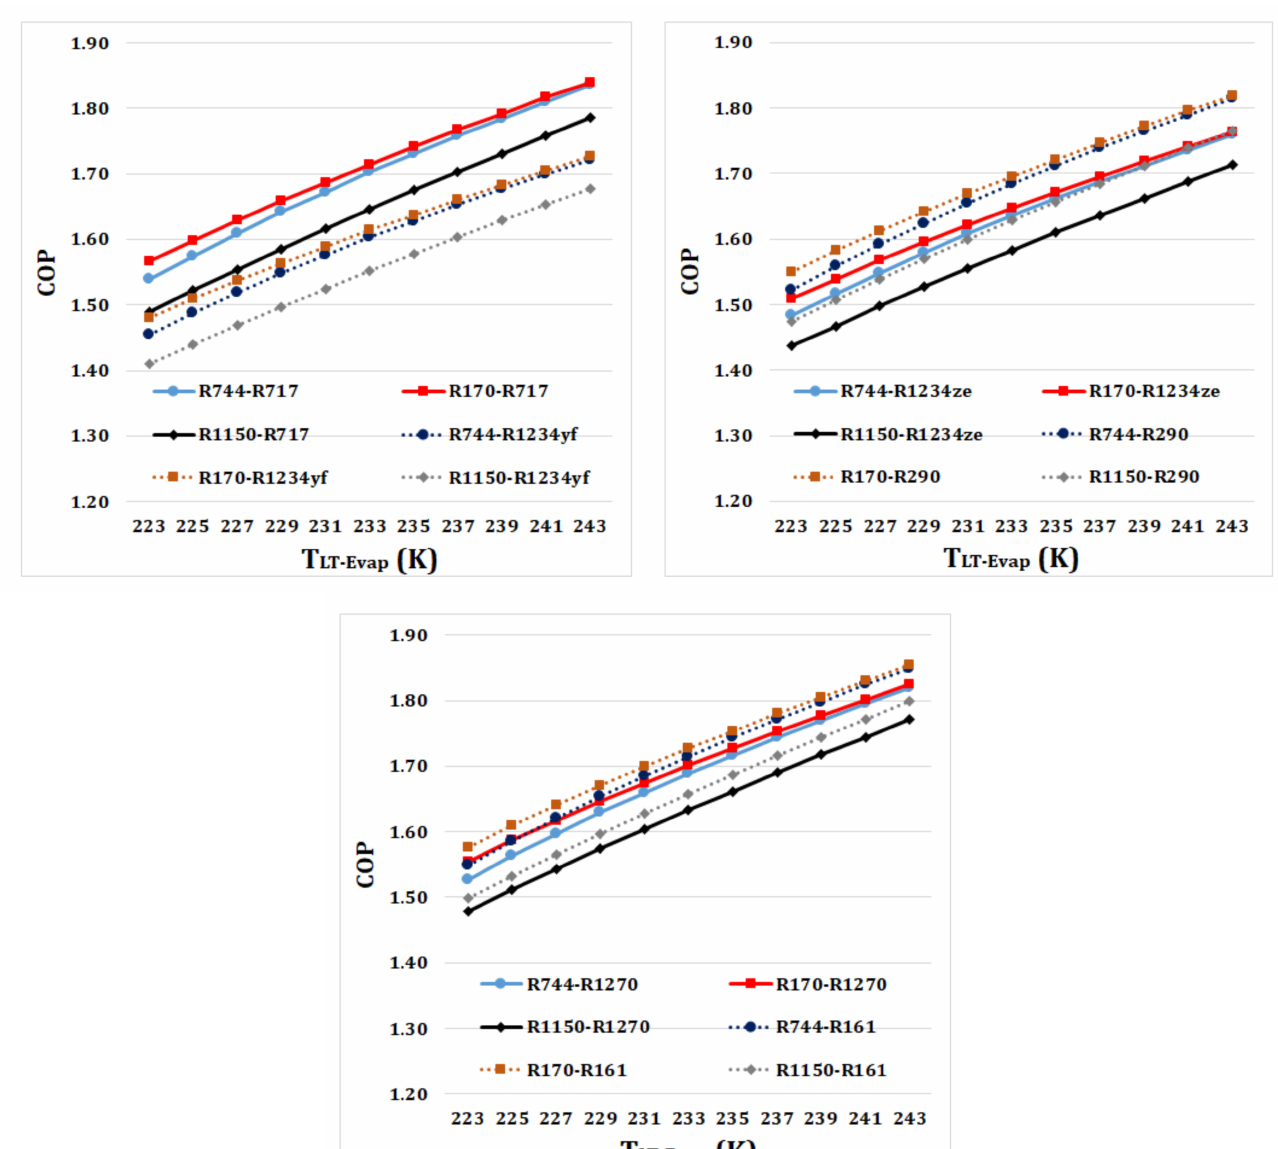
Figure 6. Effect of low-temperature evaporator ( T LT − Evap ) on the COP for different refrigerant